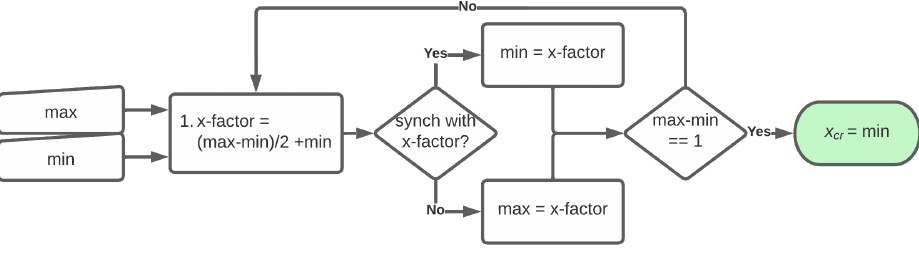
Figure 19. Flowchart implementing binary search approach to determine x cr